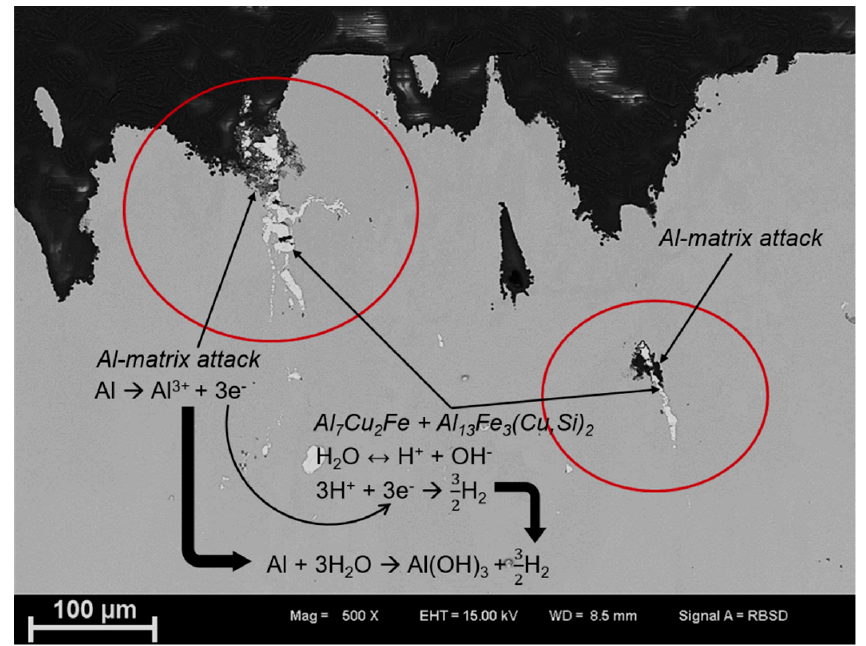
Figure 15. SEM image showing evidence of matrix attack in the vicinity of AlCuFe particles. SEM images of the corrosion front of the alloys in Figure 16 confirms IGC, pitting and grain attack as the corrosion mechanisms in T4, T6 and T76 aging, suggesting no change in corrosion mechanisms with Cr addition and with heat